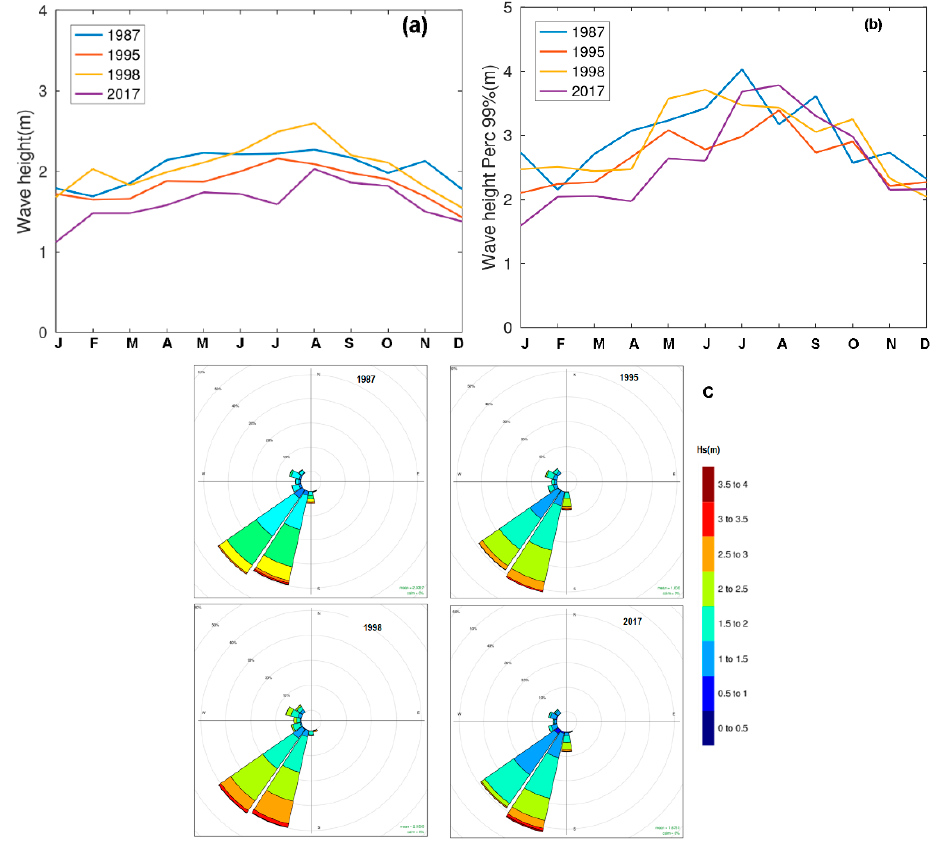
Figure 11. Wave height in deep-water of Callao Bay in 1987, 1995, 1998, and 2017. ( a ) Average significant wave height. ( b ) Percentile 99 of significant wave height. ( c ) Changes in wave height for normal years (1987 and 1995) and EN years (1998 and 2017).